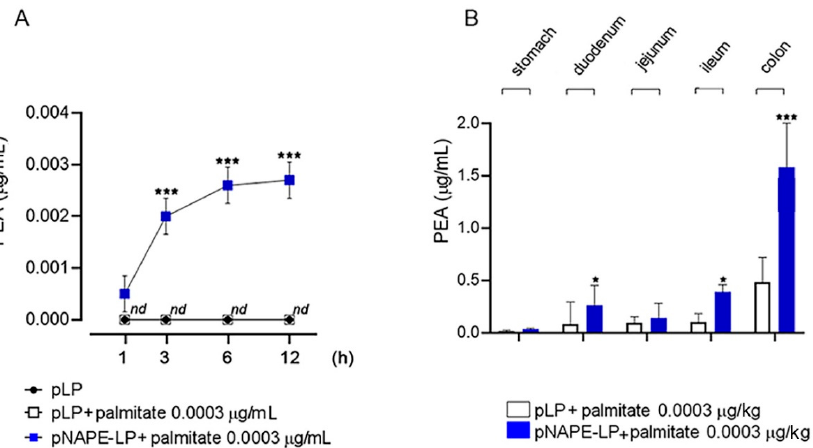
Figure 1. Palmitoylethanolamide (PEA) is time-dependently released by engineered NAPE-LP probiotic under palmitate boost. ( A ) Released PEA levels were evaluated in bacterial supernatant at 1, 3, 6, and 12 h by HPLC–MS and the results are expressed as the mean ± SD of n = 4 experiments performed in triplicate. In comparison with pLP in absence of palmitate supply, exogenous palmitate (0.0003 μ g/mL) time-dependently increased PEA release from pNAPE-LP probiotics, both *** p < 0.001 vs pLP and pLP in presence of palmitate 0.0003 μ g/mL. No detectable amount of PEA was revealed by pLP even in the presence of 0.0003 μ g/mL supplementation of exogenous palmitate. ( B ) PEA tissue concentrations evaluated in tissue homogenates from stomach, duodenum, jejunum, ileum and colon in mice treated with pNAPE-LP + palmitate 0.0003 μ g/kg or pLP + palmitate 0.0003 μ g/kg by HPLC–MS. Results are expressed, for each two groups as the mean ± SD of n = 6 experiments performed in triplicate. A significantly increased tissue concentration of PEA was observed in the duodenum and ileum of pNAPE-LP + palmitate 0.0003 μ g/kg-treated mice as compared to pLP + palmitate 0.0003 μ g/kg (+200% and +148%, respectively, both * p < 0.05), while the highest tissue concentration was reached in the colon with a 123% increase vs pLP + palmitate 0.0003 μ g/kg (*** p < 0.0001).